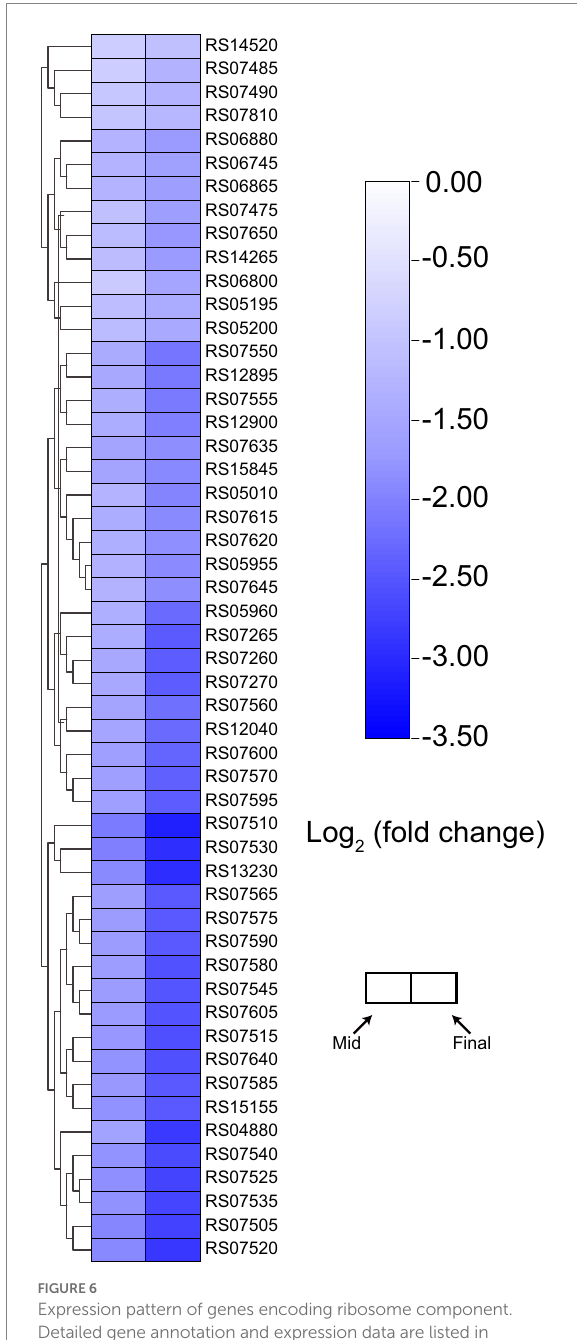
FIGURE 6 Expression pattern of genes encoding ribosome component. Detailed gene annotation and expression data are listed in Supplementary Table